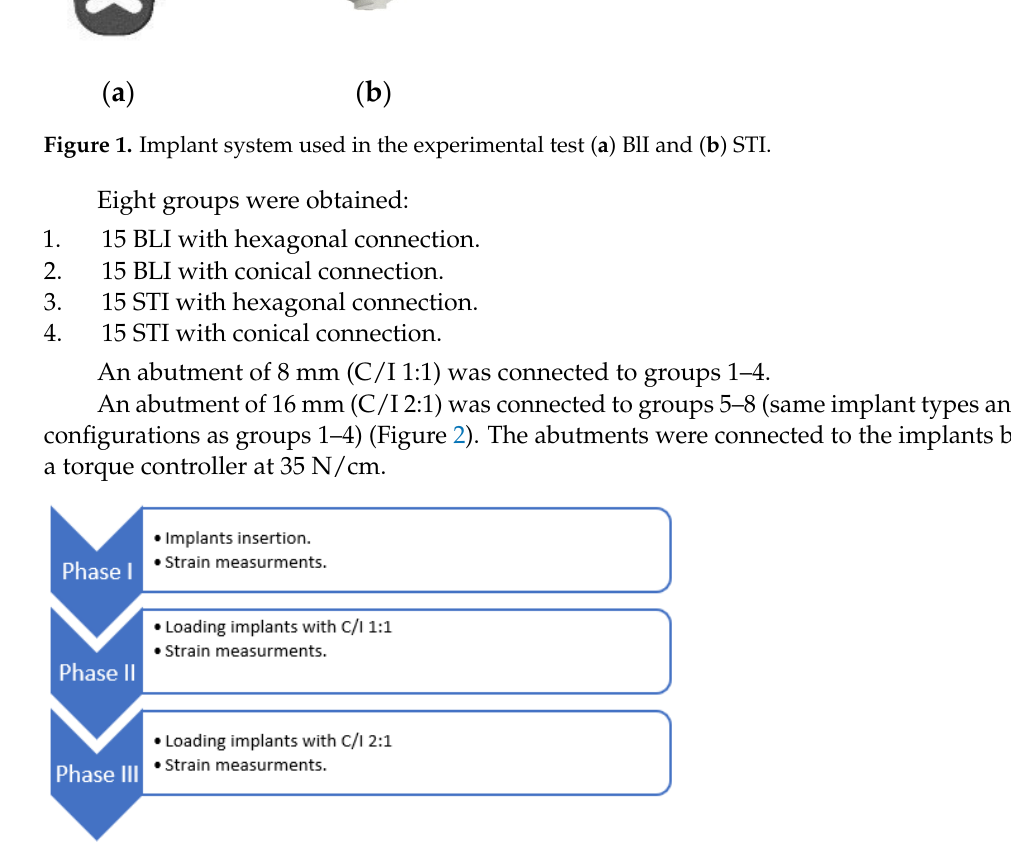
Figure 1. Implant system used in the experimental test ( a ) BlI and ( b ) STI.